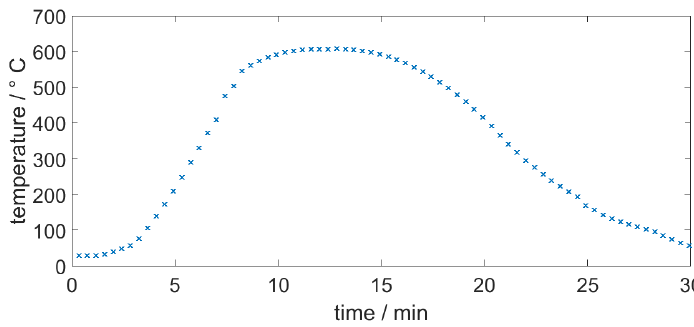
Figure 2. The measured temperature profile of the furnace for firing ground insulation.